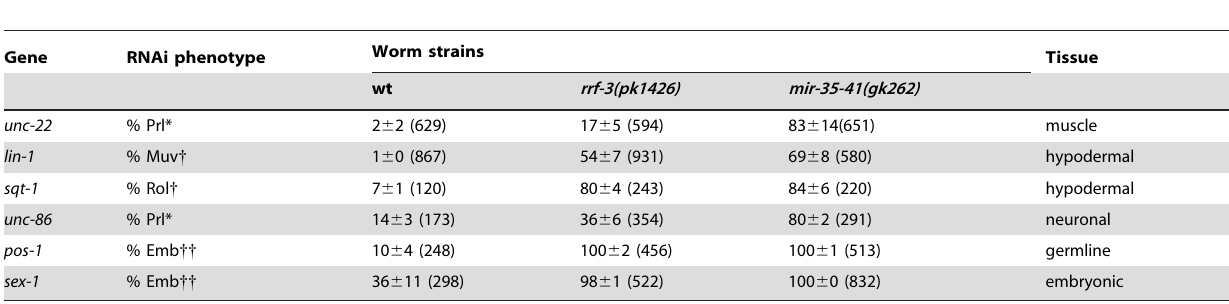
Worm strains of the indicated genotype were grown on bacteria expressing dsRNA against the indicated genes at 20 u C. RNAi phenotype results are mean 6 standard deviation (average of 3 independent experiments). Numbers in parentheses represent the total number of adult worms or embryos scored. *L4 staged worms were transferred to RNAi and the percentage of paralyzed (%Prl) adult worms was scored 28 hours later. { L1 staged worms were plated on RNAi and the percentage of adult worms showing multivulva (%Muv) or roller (% Rol) phenotypes was scored. {{ L4 staged worms were transferred to RNAi, allowed to lay embryos and adult worms were removed 28 hours later. Percent embryonic lethal (%Emb) was calculated as the number of embryos that did not